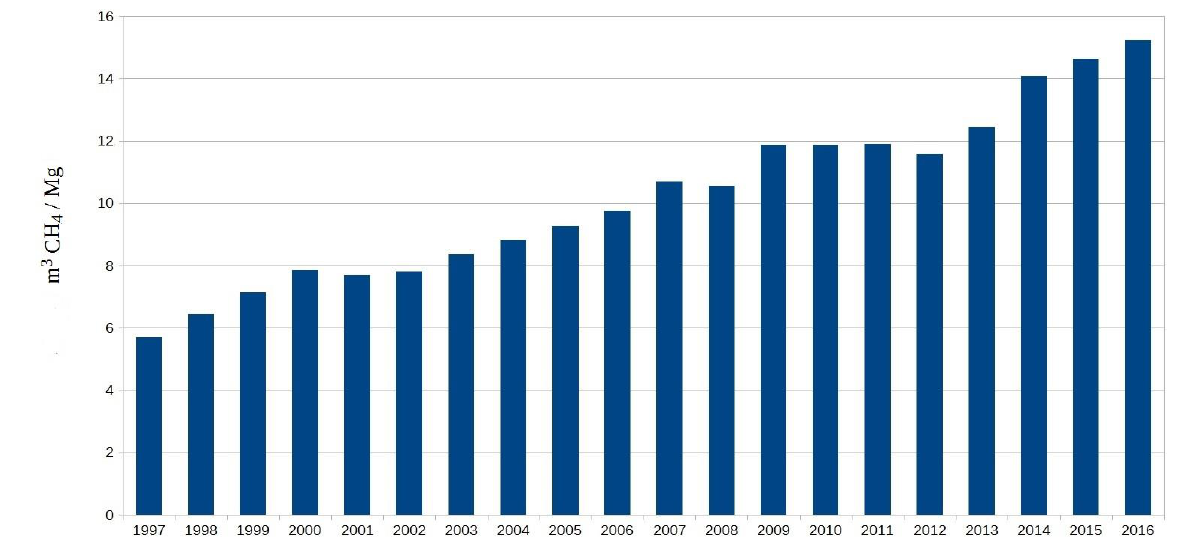
Fig. 8. Specific methane emission at